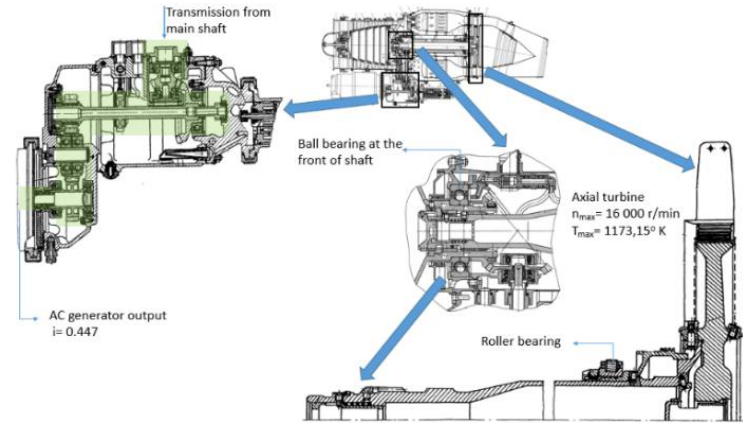
Figure 2. Cross-section of the RU-19A engine (Adapted from [17]).